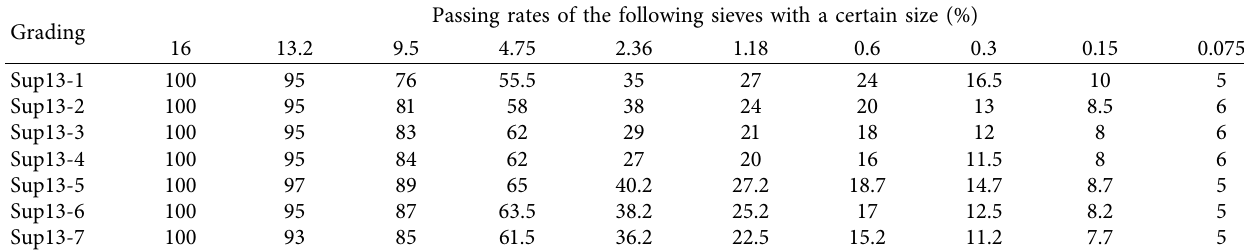
Table 1: Percentage passing of seven aggregate